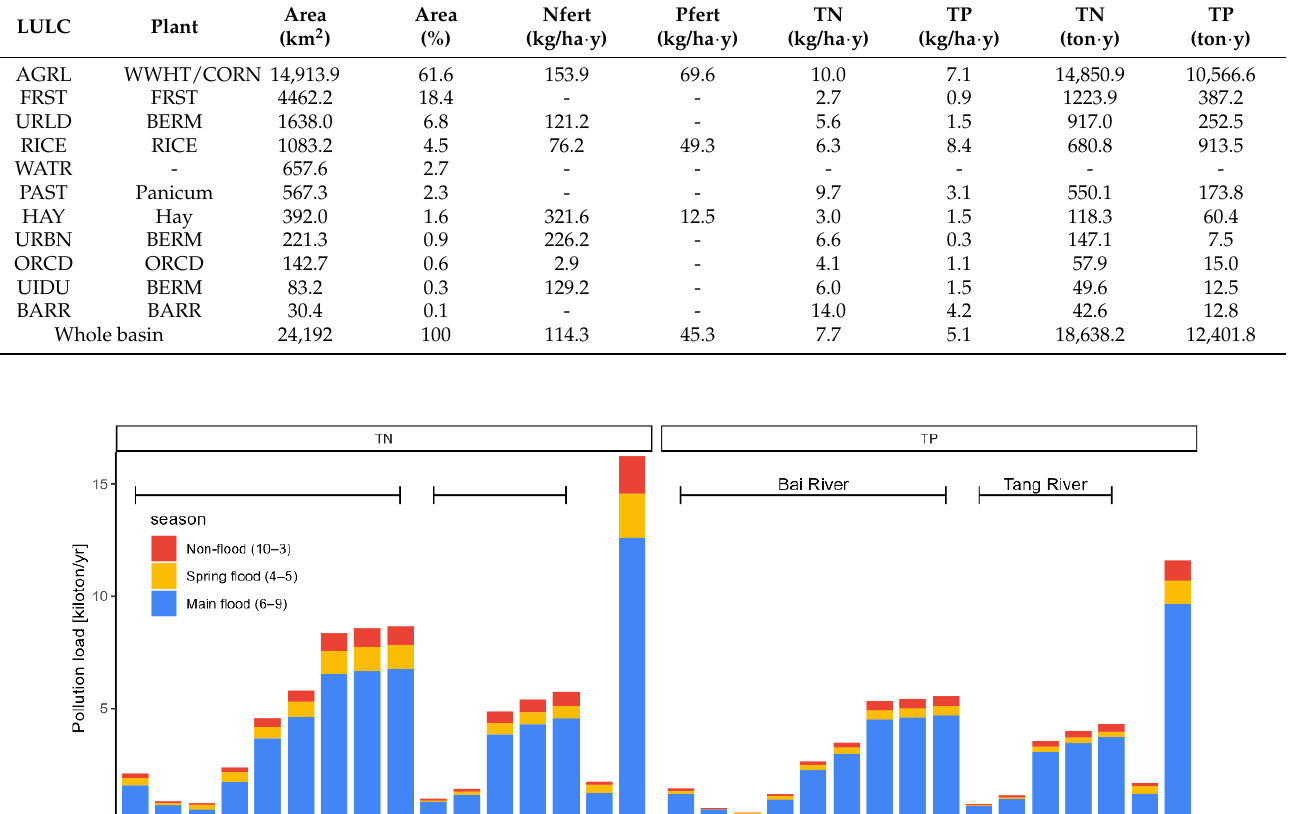
Table 3. The type of plant, area and area ratio, elemental nitrogen, and phosphorus fertilizers applied through calendar fertilization and auto-fertilization in HRU (Nfert, Pfert, see Section 2.2.2), and total N and total P transport from a certain HRU into reach (TN, TP) in load and load per unit area per year for individual land-use/land-cover (LULC) classes.